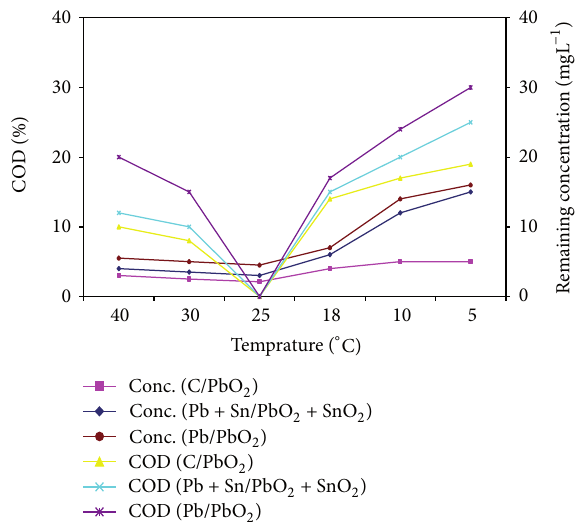
F 4: e effect of the conductive electrolyte type on RY160 and COD removal using C/PbO electrodes.